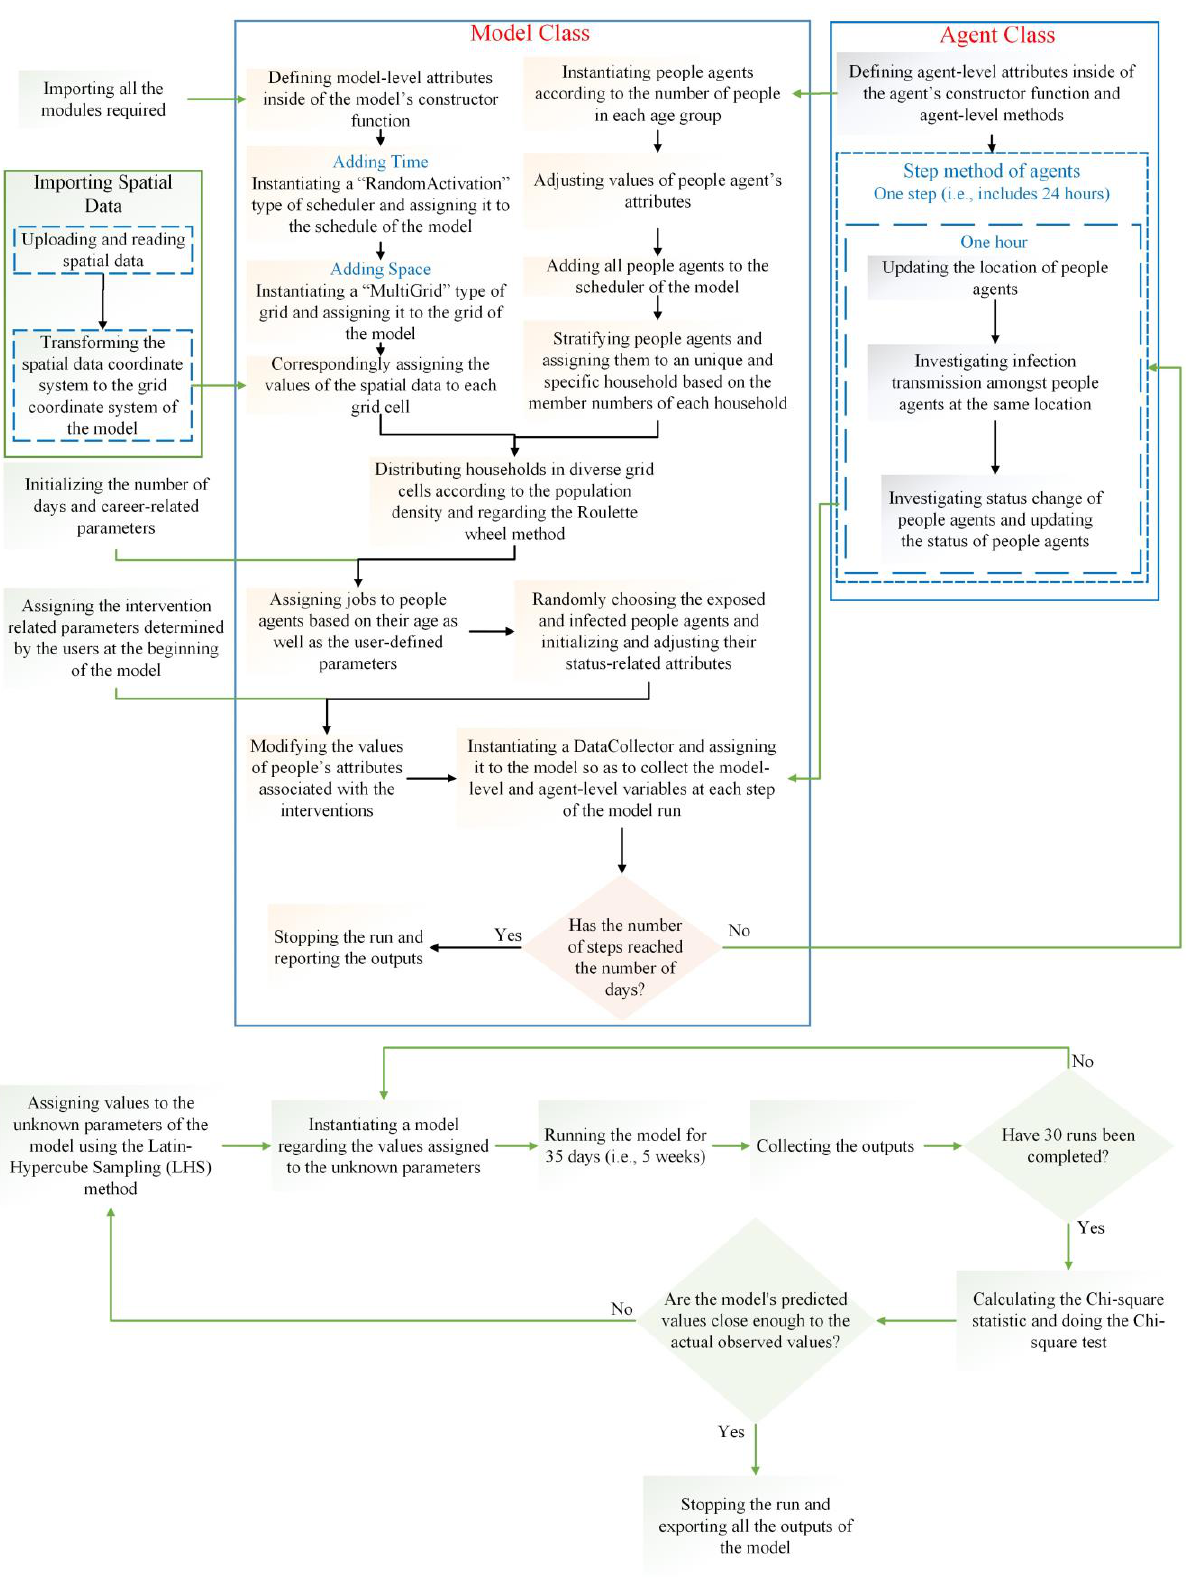
Figure A1. Code implementation processes in Mesa.